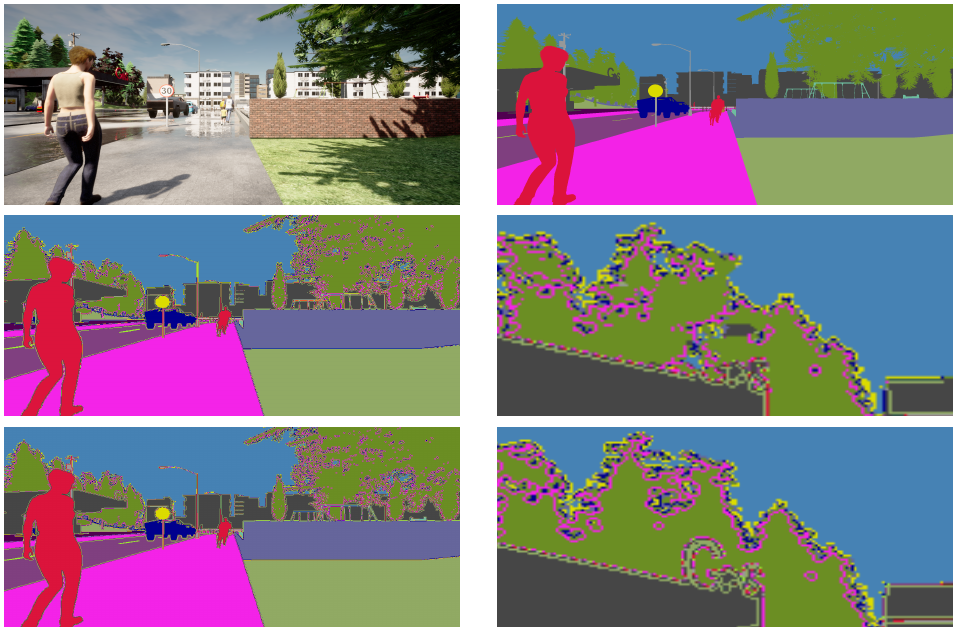
Figure 5. Qualitative evaluation, scenario 2. From the top down, a sample snippet (sidewalk with pedestrians, traffic signs, and contextual information of building) is presented with its ground-truth annotation, segmentation prediction maps with a zoom-in for detail depiction, from GSVNET SN-R18 and our SN-R18